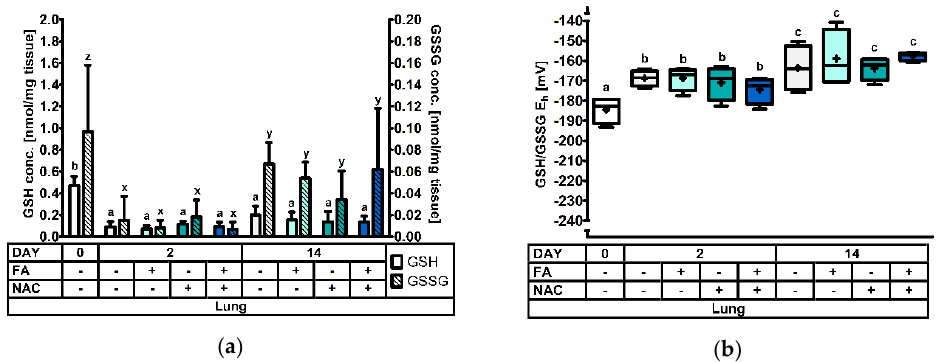
Figure 4. The glutathione redox system in lung tissue of piglets at 0d, 2d, and 14d post-weaning (DAY), either ad libitum fed (FA − ) or fasted (FA+) the first 2d post-weaning, and either provided standard drinking water (NAC − ) or water supplemented with 200 mg/L N -acetyl cysteine (NAC+)